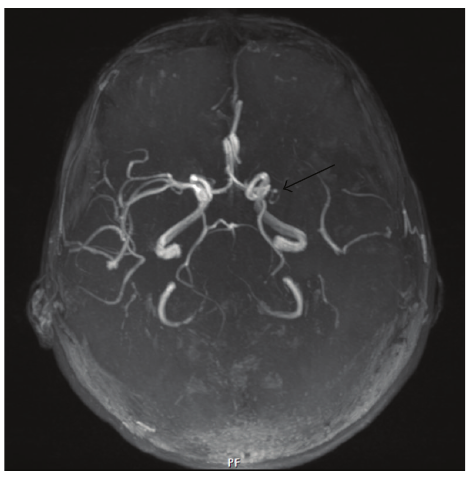
Figure 1: Infarct region compatible with large-size MCA infarct in left frontotemporoparietal lobes on cerebral MRI.